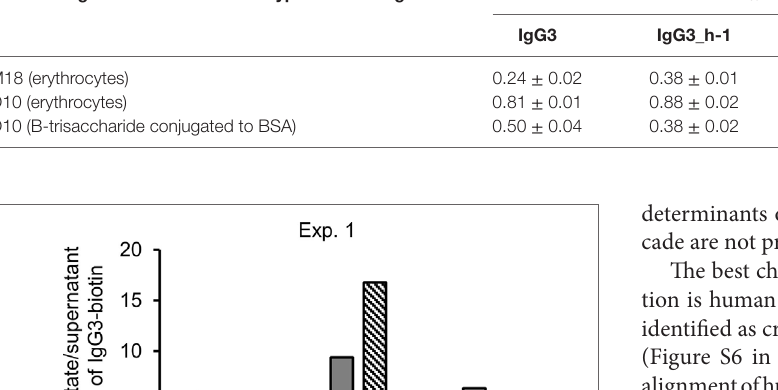
TaBle 4 | EC 50 of mutein binding to the antigen calculated using data from Figure 3 . Variable region of the mutein and type of the antigen